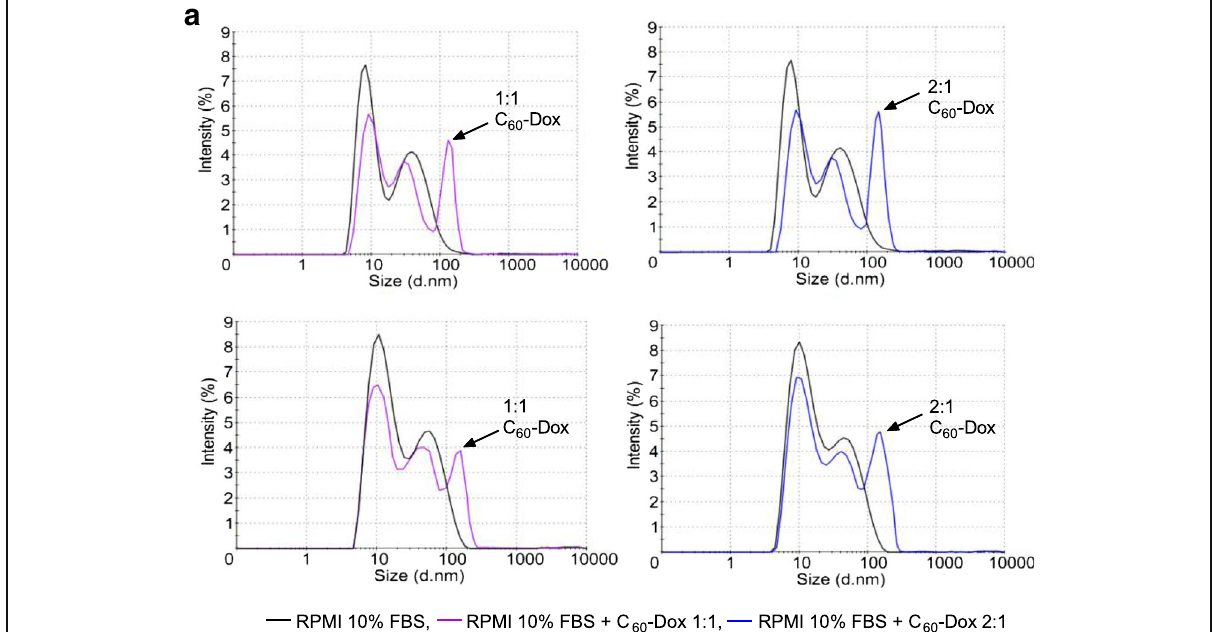
Fig. 3 Hydrodynamic size (diameter, nm) of 1 μ M С 60 -Dox complexes in RPMI cell culture medium supplemented with 10% FBS at 0 ( a ) and 72-h ( b ) incubation. Intensity (%) percentage of all scattered light